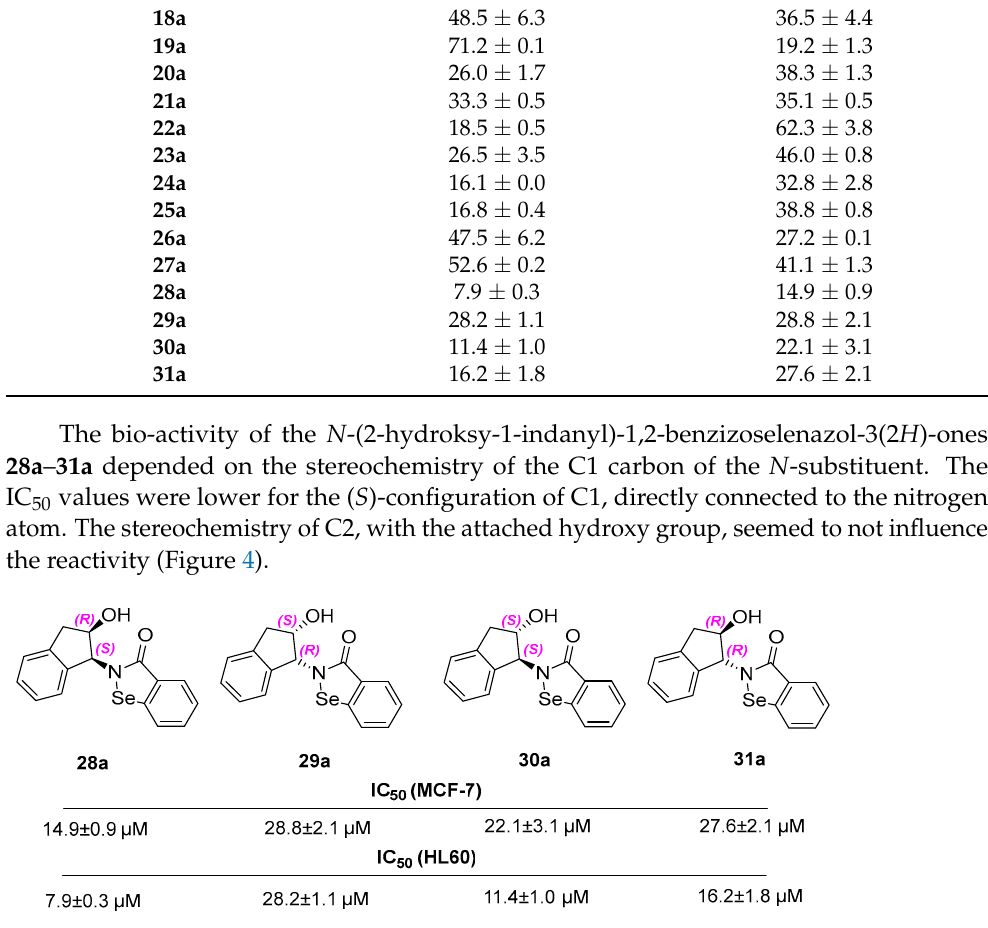
Figure 4. Different activity of diastereomeric hydroxyindanyl derivatives 28a – 31a. The corresponding diselenides only expressed cytotoxicity towards the HL-60 cell line, except for derivative 20b (IC 50 37.00 ± 4.25 µ M). This suggests that the Se–N bond is needed to influence the proliferation of MCF-7 cells. Additionally, the cytotoxic activity was exclusively observed for diselenides bearing an additional hydroxy group. The hydroxybuthyl derivatives 20b and 21b gave the lowest IC 50 values 8.67 ± 0.14 µ M and 10.10 ± 0.49 µ M, respectively. Most potent compounds were also evaluated using human endothelial cells HUVEC. The N - trans -2-hydroksy-1-indanyl diselenide 31b revealed a selective antiproliferative activity with no toxicity towards normal cells (Table 3). Table 3. The antiproliferative activity of compounds 18b – 31b.